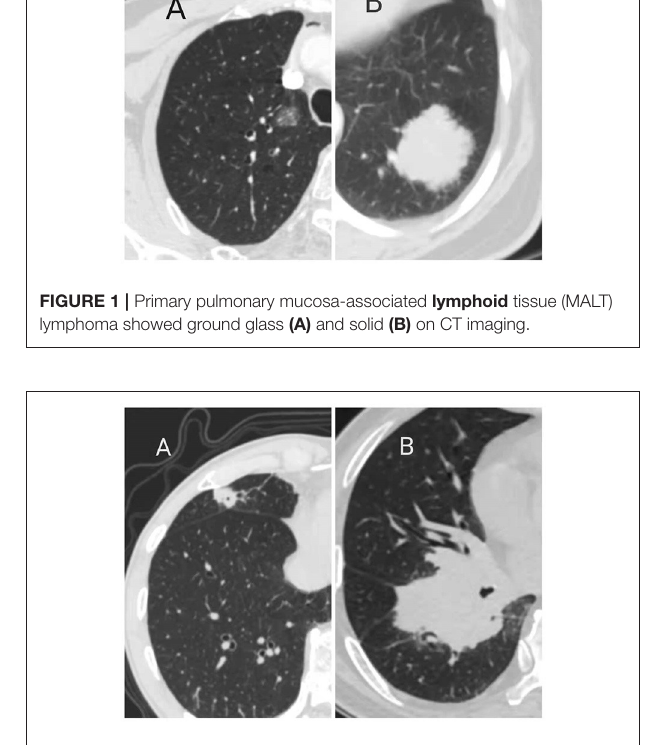
FIGURE 3 | Kaplan-Meier survival curves for relapse-free survival (RFS) (above) and overall survival (OS) (below) according to lobectomy and